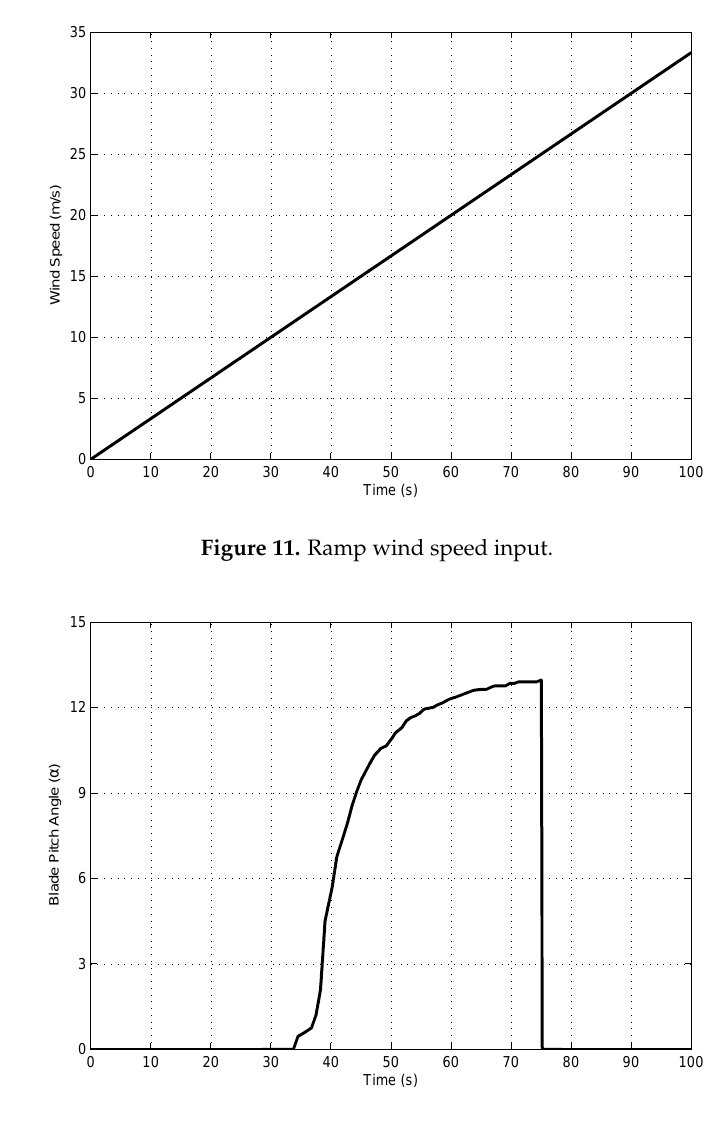
Figure 12. Comparison of output power generated by proportional-integral (PI) and the fuzzy